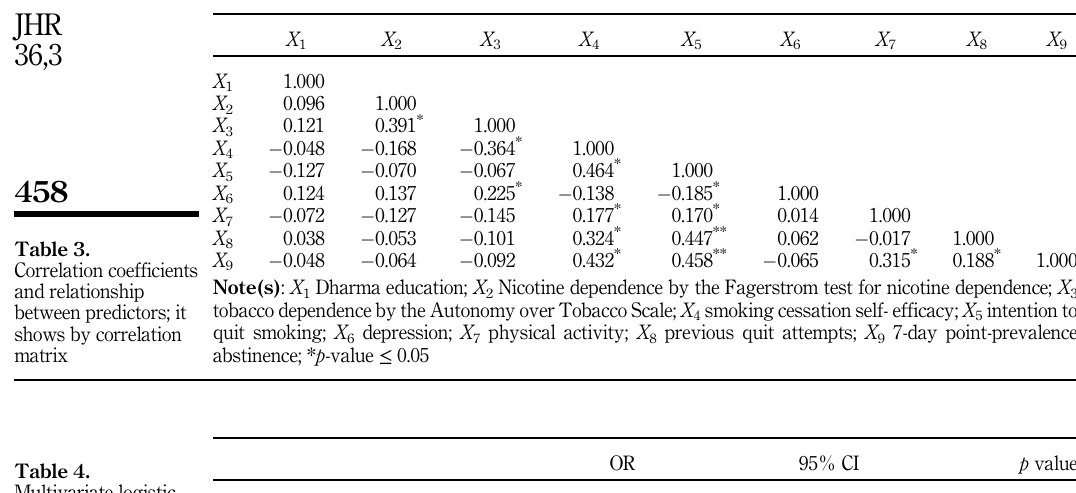
Table 4. Multivariate logistic regression analyses on predictors of three- month smoking abstinence ( n 5